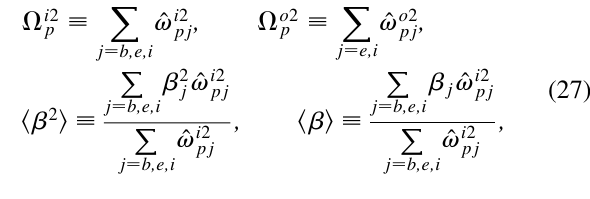
r =c (cid:7) 3 (Fig. 9). Figures 8 and 9 show (Fig. 8), and (cid:30) i b p plots of the normalized growth rate (cid:1) Im ! (cid:2) = " radial mode number n and plots of the eigenfunction (cid:1) r (cid:2) versus r=r (cid:31) ^ E for radial mode number n (cid:7) 5 . For z w